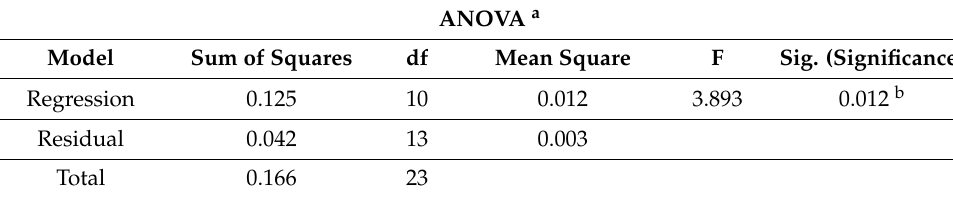
Table 10. Analysis of variance (ANOVA) of the regression analysis